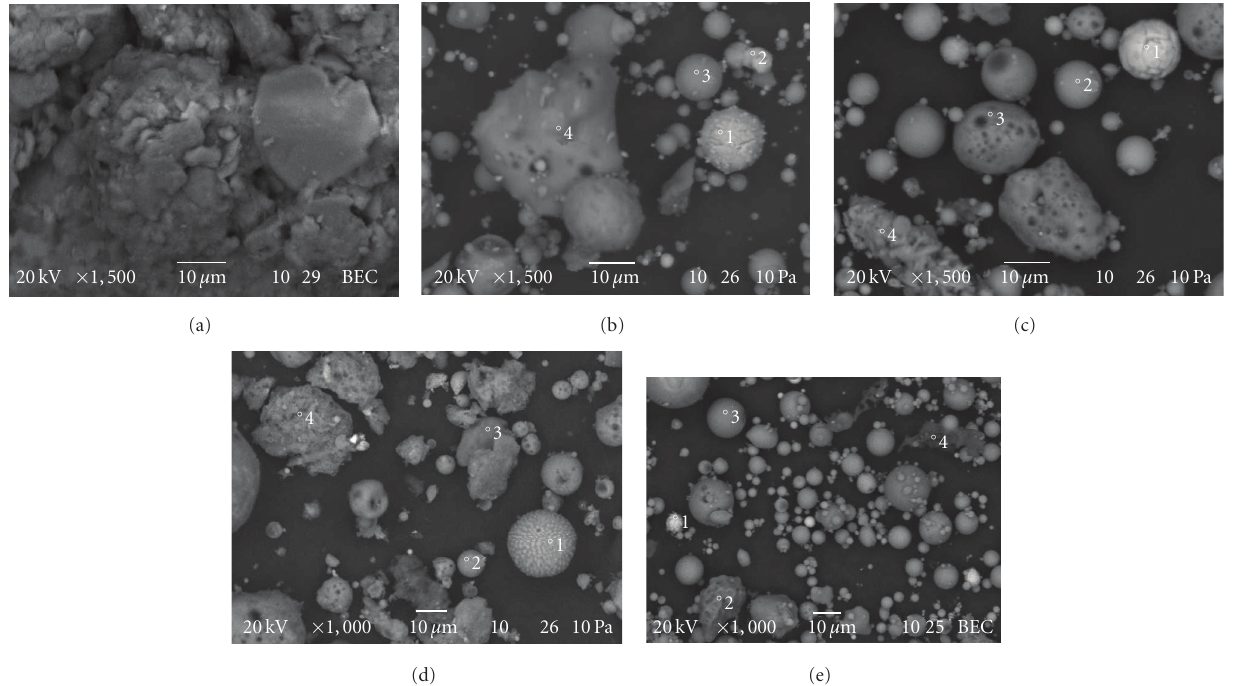
Figure 2: SEM micrographs of fly ashes (a) Soil × 1500 (b) C × 1500 (c) OE × 1500 (d) SO × 1000 (e) T × 1000.